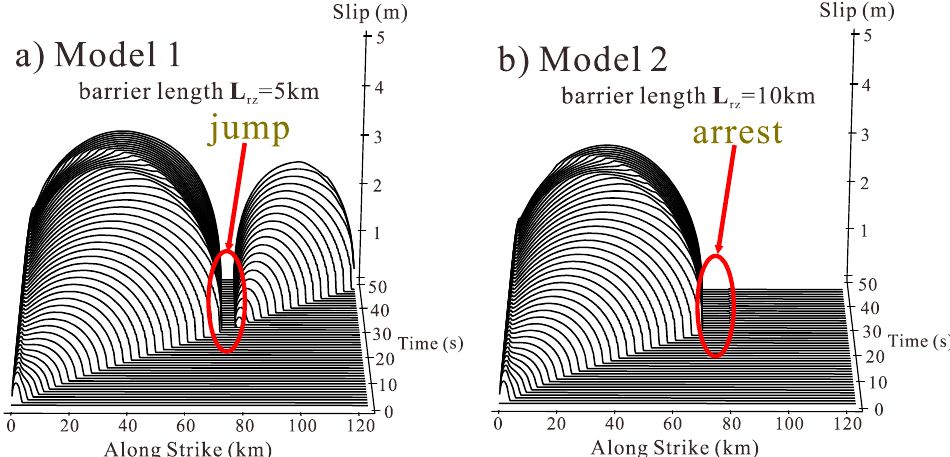
Figure 9. ( a ) Distribution diagram of the slip along the interface over time of Model 1. ( b ) Distribution diagram of the slip along the interface over time of Model 2.